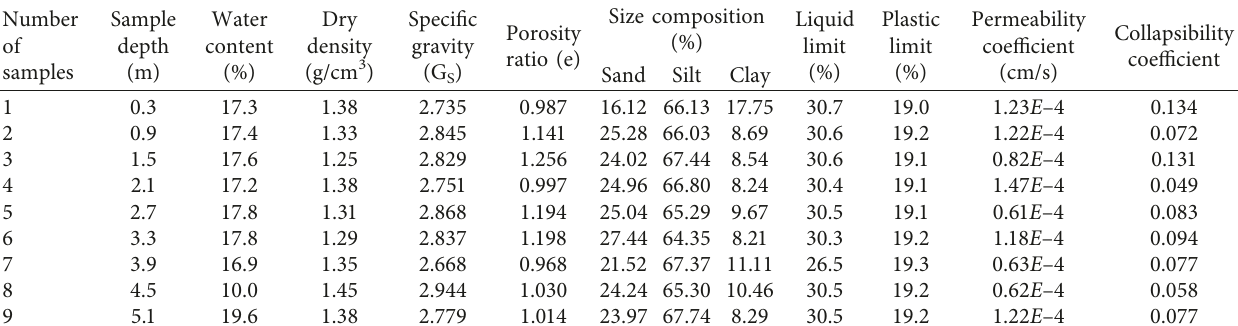
Figure 3: The grain diameter distribution map of Malan loess measured by laser particle size analyzer (Dandong Bettersize 2000). Table 1: Physical and mechanical properties of the three-level terraced loess in Jinjiaya